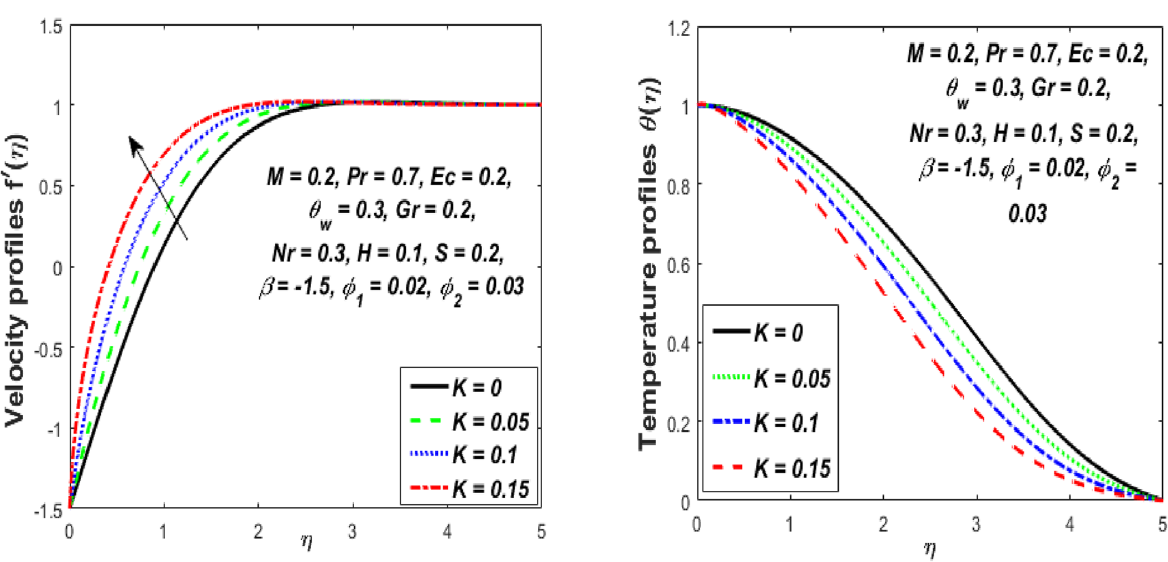
Figure 4. Influence of K on velocity f ′ (η) and temperature θ(η)